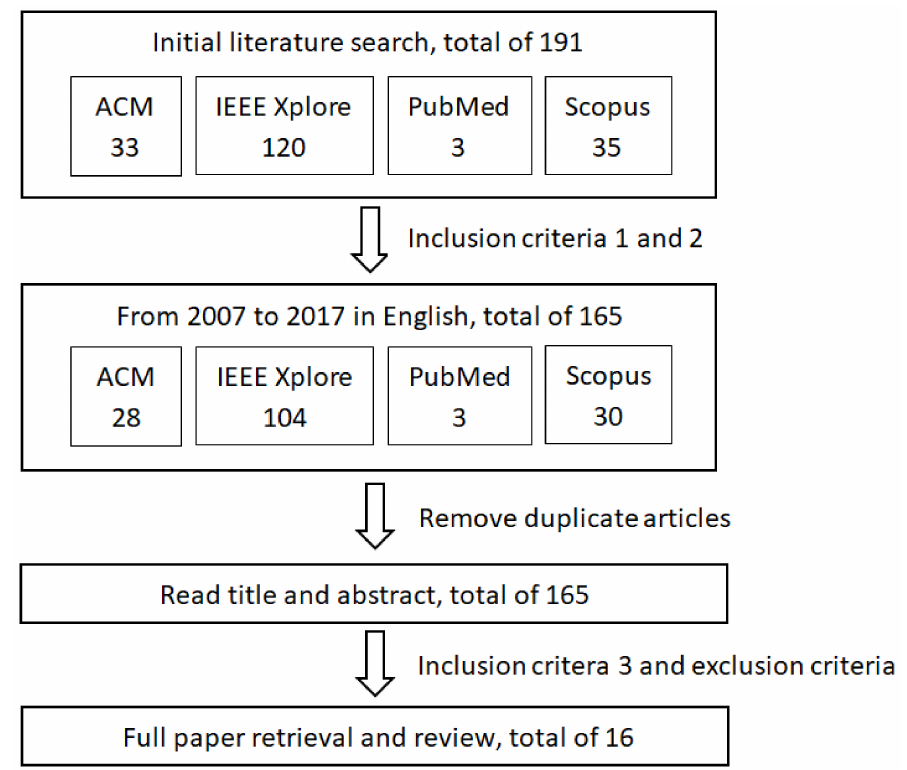
Figure 1. Research method: Flow diagram of the search and review